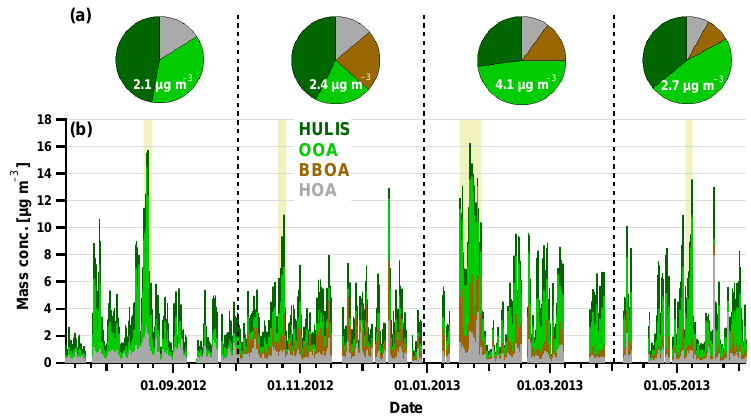
Figure 4. Overview of ACSM PMF factors. (a) Seasonal pie charts of the factor contributions. The respective average total organic concen- tration is written inside the pie chart. (b) Stacked time series of mass concentrations. Shaded areas represent highly polluted